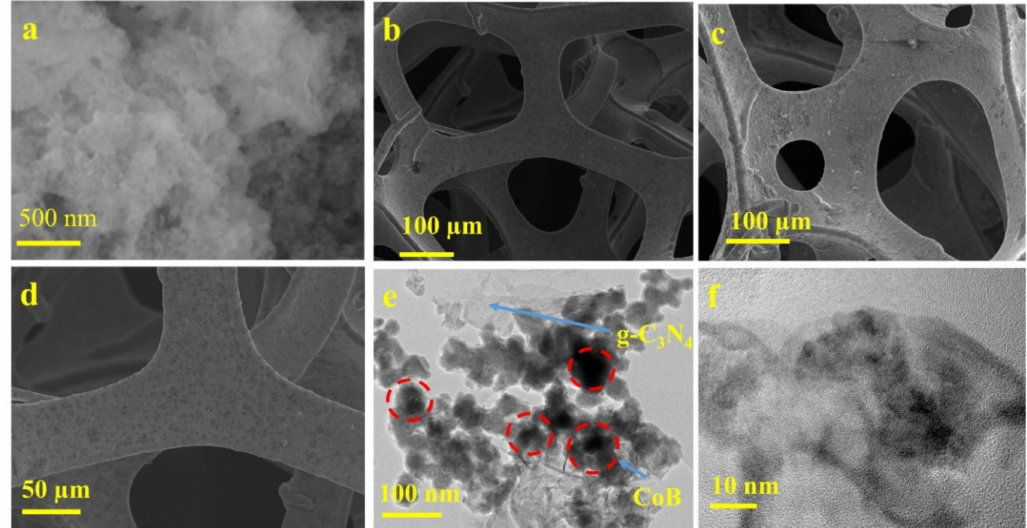
Figure 1. ( a ) SEM of CoB/g-C 3 N 4 high magnification, ( b ) SEM of bare nickel foam, and ( c , d ) SEM of CoB/g-C 3 N 4 @NiF, ( e , f ) TEM of CoB/g-C 3 N 4 at low and high magnification, respectively.